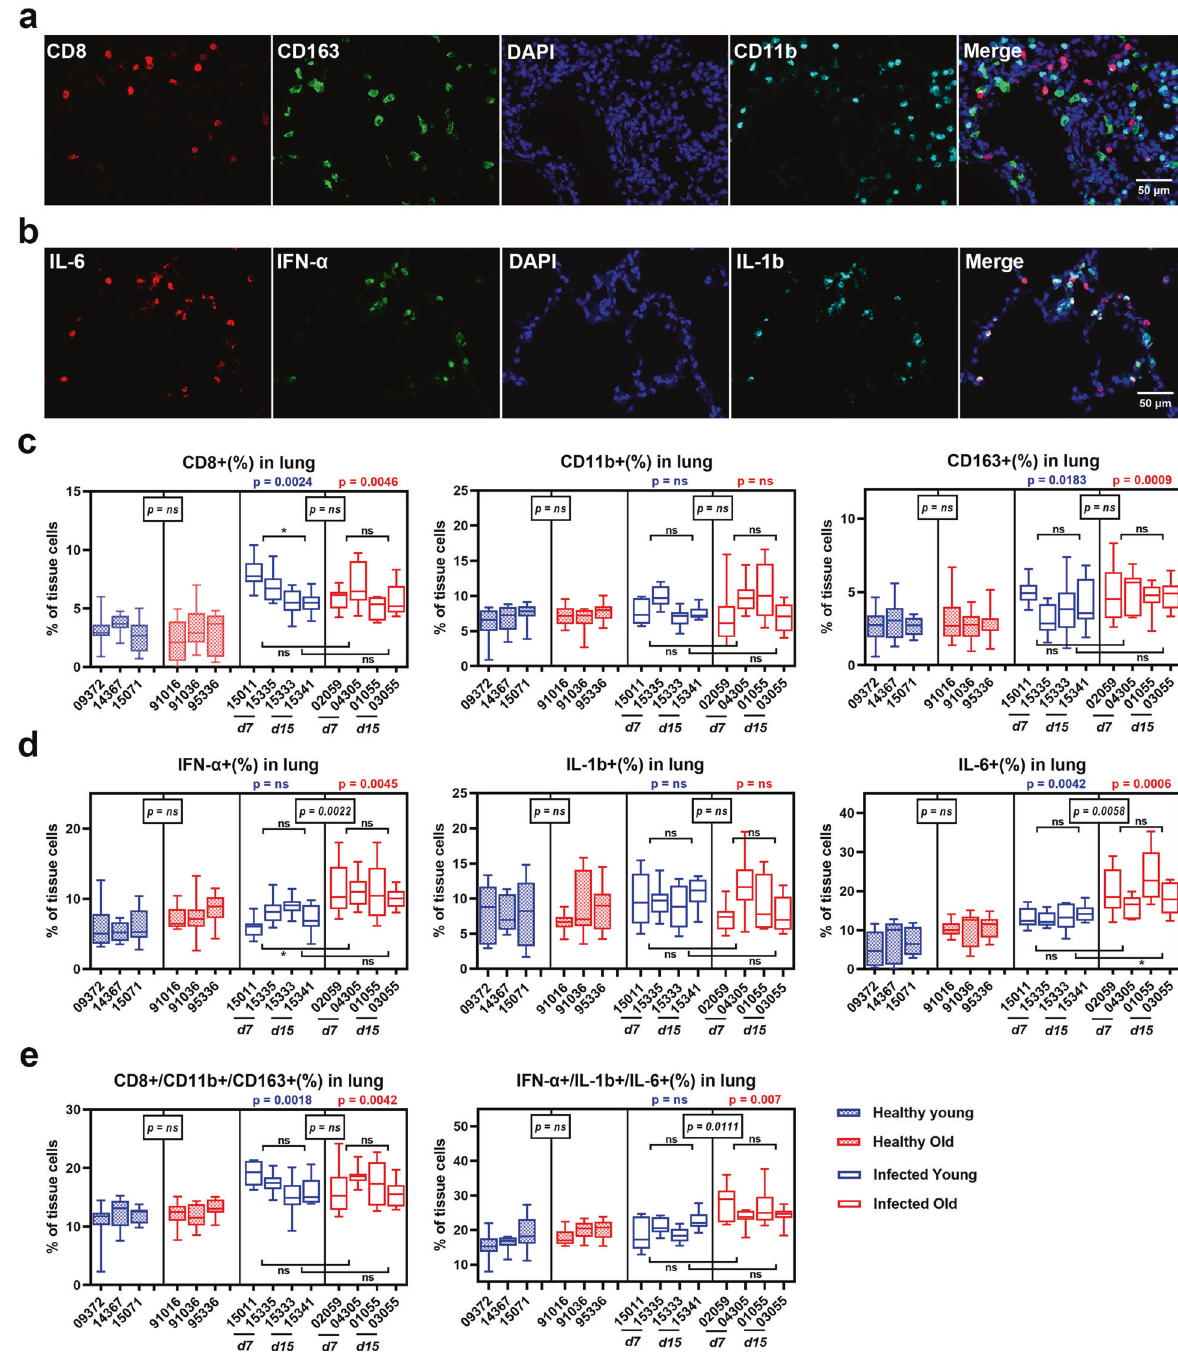
Fig. 3 SARS-CoV-2-induced in fl ammatory cell in fi ltration in lung tissue of old RMs. a , b mIF images showing the co-staining results of in fl ammatory cells ( a ) and in fl ammatory factors ( b ) in lung tissue sections. Red, green, and cyan indicate staining of protein markers, and blue DAPI staining indicates nucleus. c – e Box plots showing the staining results according to a and b in healthy young, healthy old, infected young, and infected old groups. Data calculated using 10 microscopy images of lung tissue sections from each animal are shown as median with min to max. P value marked in blue indicates the comparison between infected and healthy young groups, and red indicates the comparison between infected and healthy old groups. Boxed p value represents a comparison between young and old RMs in healthy (left) or infected (right) conditions. Square brackets in the fi gure show a comparison between infected young and old RMs at different time points (7 and 15 DPI). * p ≤ 0.05; ns, p > 0.05 mediated pro-in fl ammatory signaling pathways during infec- is evidence that the expression of ACE2 in the lung is greatly tion 31,32 . Similar to that reported in COVID-19 patients, we found reduced with aging 29 . However, compared with younger patients, elderly patients exhibit a higher severity of lung injury and higher lower ACE2 + cell density in the lungs of healthy old RMs mortality rate from COVID-19 30 . This may be owing to lower ACE2 compared with healthy young RMs, although levels declined rapidly in both young and old RMs after infection. This suggests expression in the elderly promoting activation of angiotensin II- Signal Transduction and Targeted Therapy (2021)